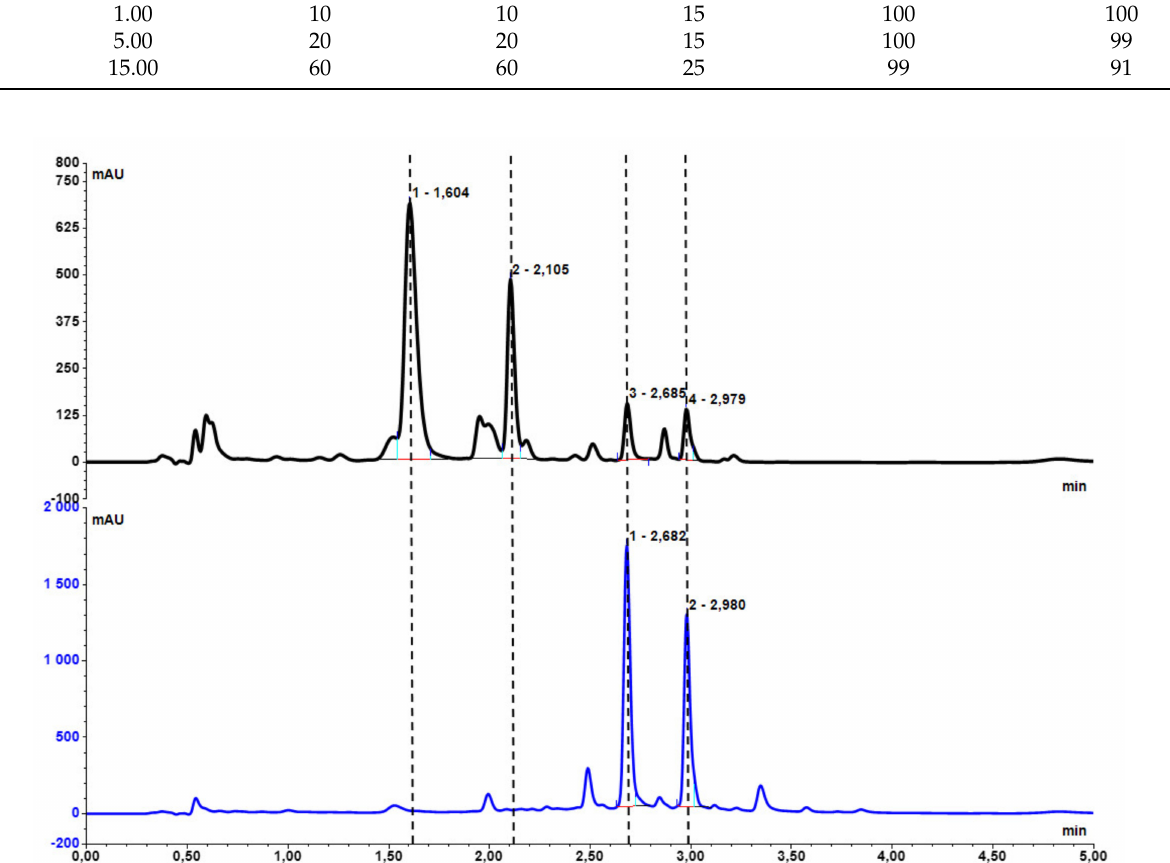
Figure 3. UHPLC chromatograms of methanolic extract of dry root of Scutellaria baicalensis L. (black) and methanolic extract of dry root after hydrolysis (blue): baicalin ( 1 ) Rt = 1.60 min, wogonoside ( 2 ) Rt = 2.10 min, baicalein ( 3 ) Rt = 2.68 min, wogonin ( 4 ) Rt = 2.98